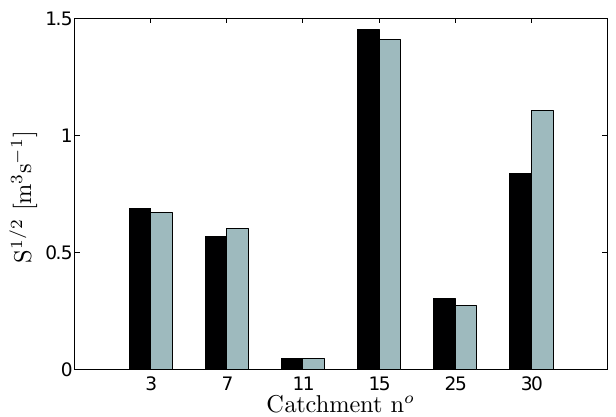
Fig. 5. Actual (black) vs. estimated (grey) root squared spectral den- sity ( k = 0) of the discharge time series for the six autochthonous catchments in the case of temporal gauging divergence (period 2006–2007). The estimates are root squared densities of the au- tochthonous discharge time series during the period